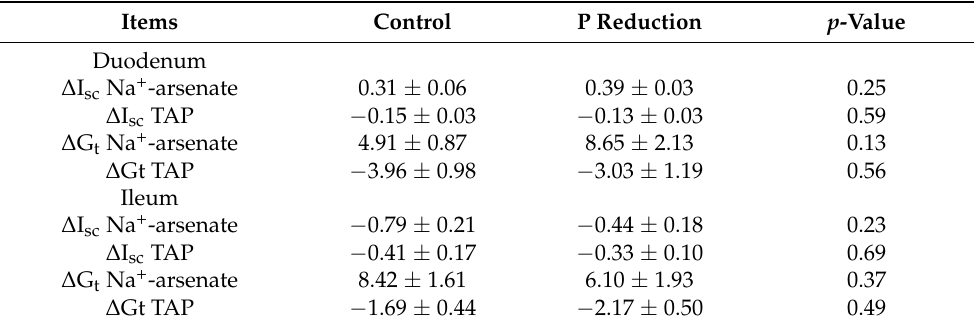
Figure 3. Effect of adding 20 mmol/L TAP to the mucosal side of duodenal epithelia on the short-circuit current (I sc ) ( a ) and the tissue conductance (G t ) ( b ). Effect of adding 20 mmol/L TAP to the mucosal side of ileal epithelia on the short-circuit current (I sc ) ( c ) and the tissue conductance (G t ) ( d ). Table 6. Changes in tissue conductance ( ∆ G t ) and short-circuit current ( ∆ I sc ) after mucosal addition of Na + -arsenate and 2,4,6-triaminopyrimidine (TAP) in duodenum and ileum of young goats fed a low phosphorus (P) diet. (Mean values with their standard errors; n = 7 animals).